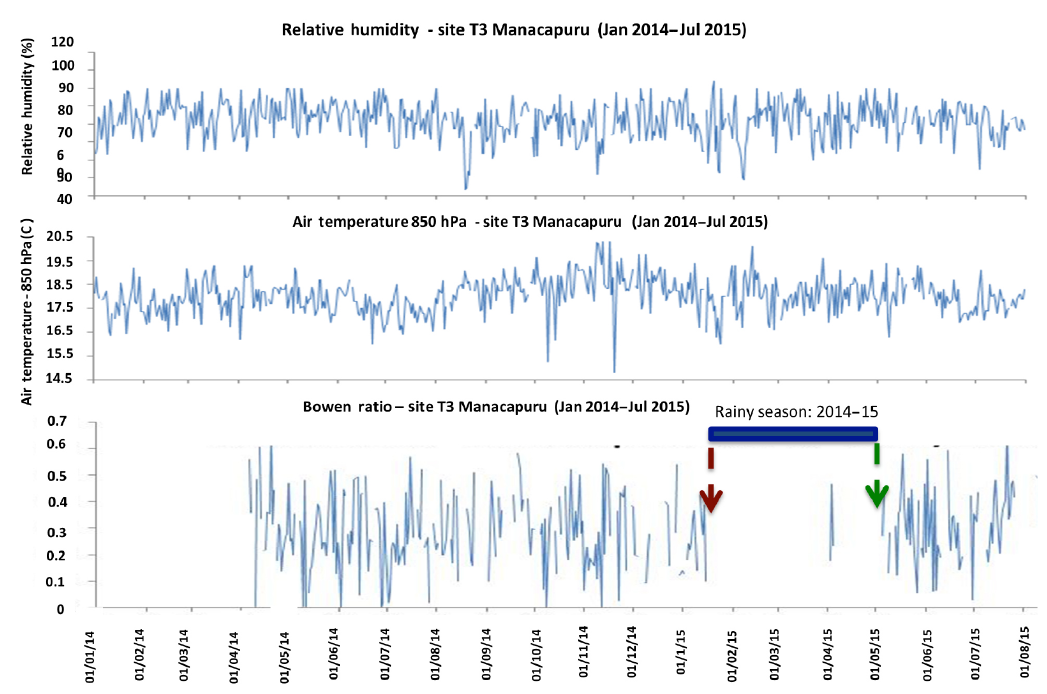
Figure 6. Daily variation of relative humidity (%), 850hPa air temperature ( ◦ C) and Bowen ratio at the T3 Manacapuru site, from Jan- uary 2014 to July 2015. The blue bar indicates the onset and end of the rainy season for 2014–2015. No Bowen ratio data were available during some days between January 2014 and July